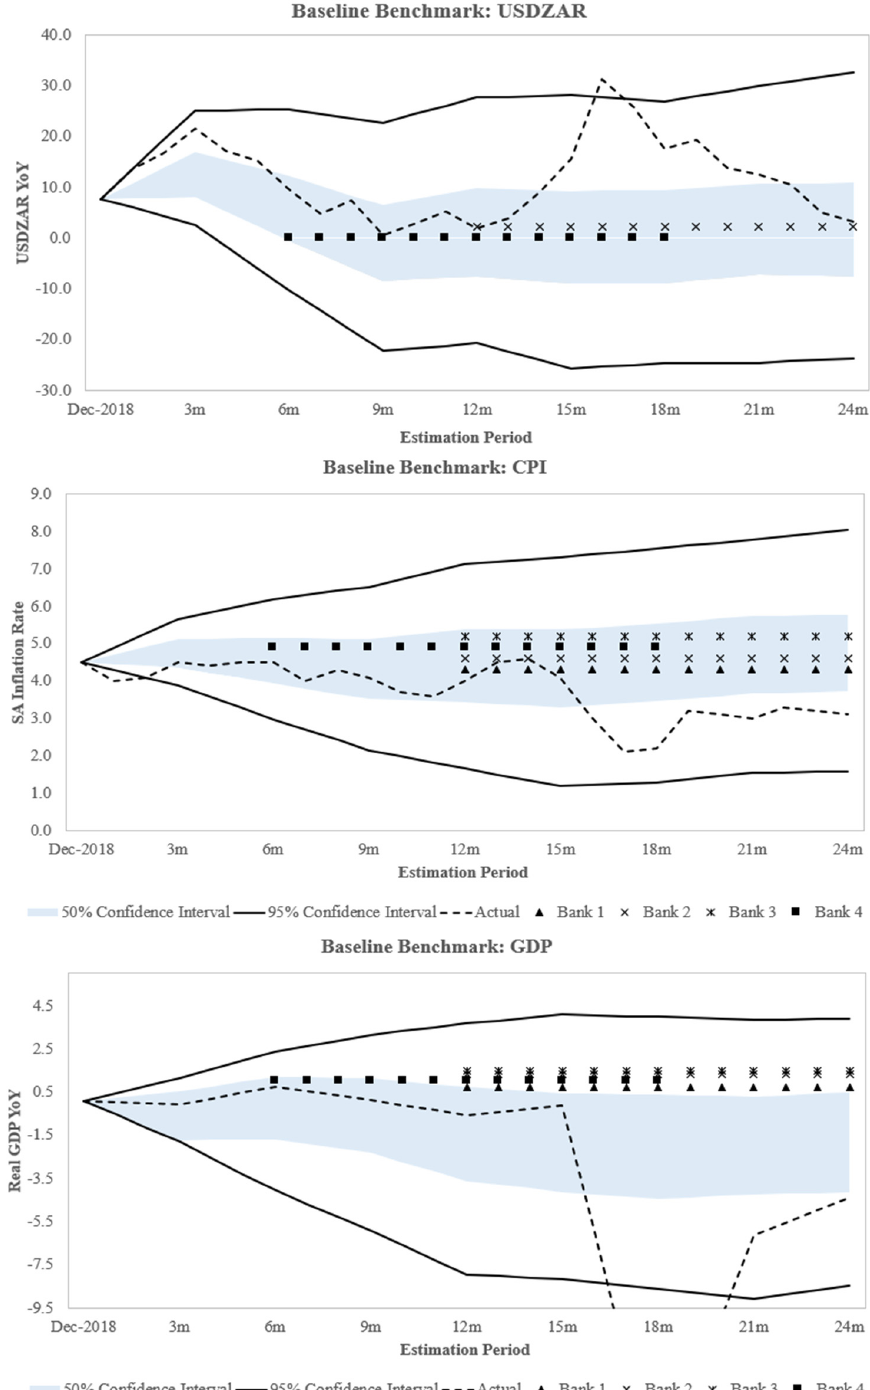
Figure 7. Illustrating the benchmark approach for the baseline scenarios as published in the annual financial statements of the South African banks for FYE